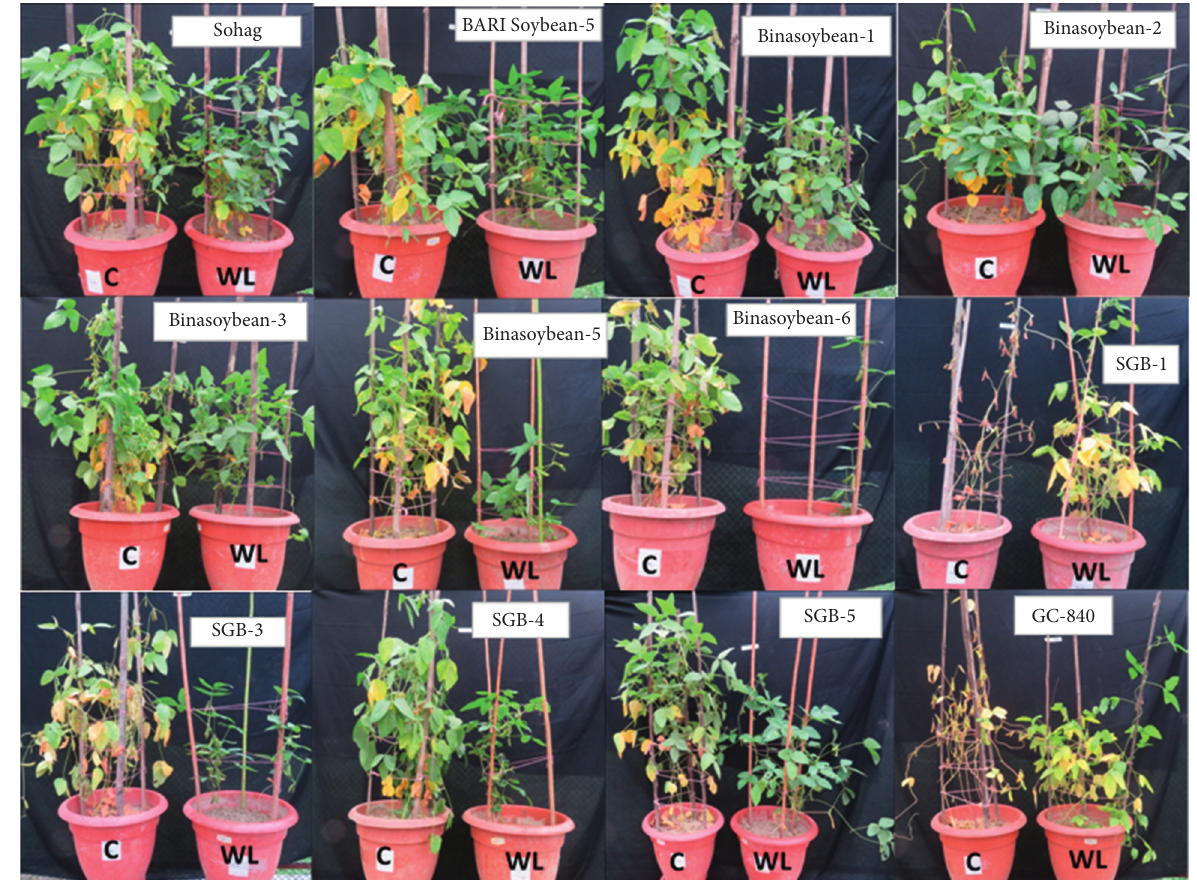
Figure 8: Phenotypic variations of soybean under waterlogged and control condition at 75 DAS. Here, C denotes control and WL waterlogged